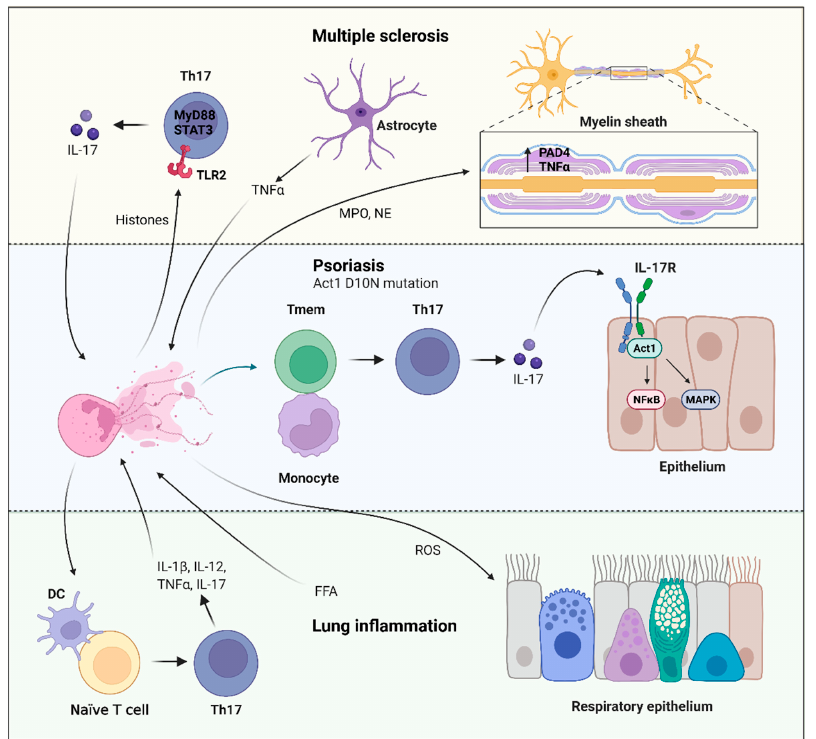
Figure 3. Neutrophil extracellular trap (NET) induction of T helper 17 (Th17) cells in disease. Mul- tiple sclerosis (MS): Histones released from NETosis can directly trigger Th17 differentiation via Toll-like receptor 2 (TLR2) and myeloid differentiation primary response 88 (MyD88), activating signal transducer and activator of transcription (STAT3), which is critical for Th17 function [204,205]. The secretion of interleukin-17 (IL-17) from the Th17 cells recruit more neutrophils [206], creating a proinflammatory feedback loop. Astrocytes can also release tumor necrosis factor α (TNF α ), which can prime neutrophils for NETosis [125], contributing to further local inflammation. Elevated myeloperoxidase (MPO) and neutrophil elastase (NE)-DNA immune complexes have been shown to correlate with MS disease severity [126–129]. Elevated nuclear levels peptidyl arginine deiminase 4 (PAD4) and TNF α were detected before demyelinating disease. Psoriasis: Loss of func- tion mutation in Act1, D10N, has been associated with disease susceptibility [193–196]. With these